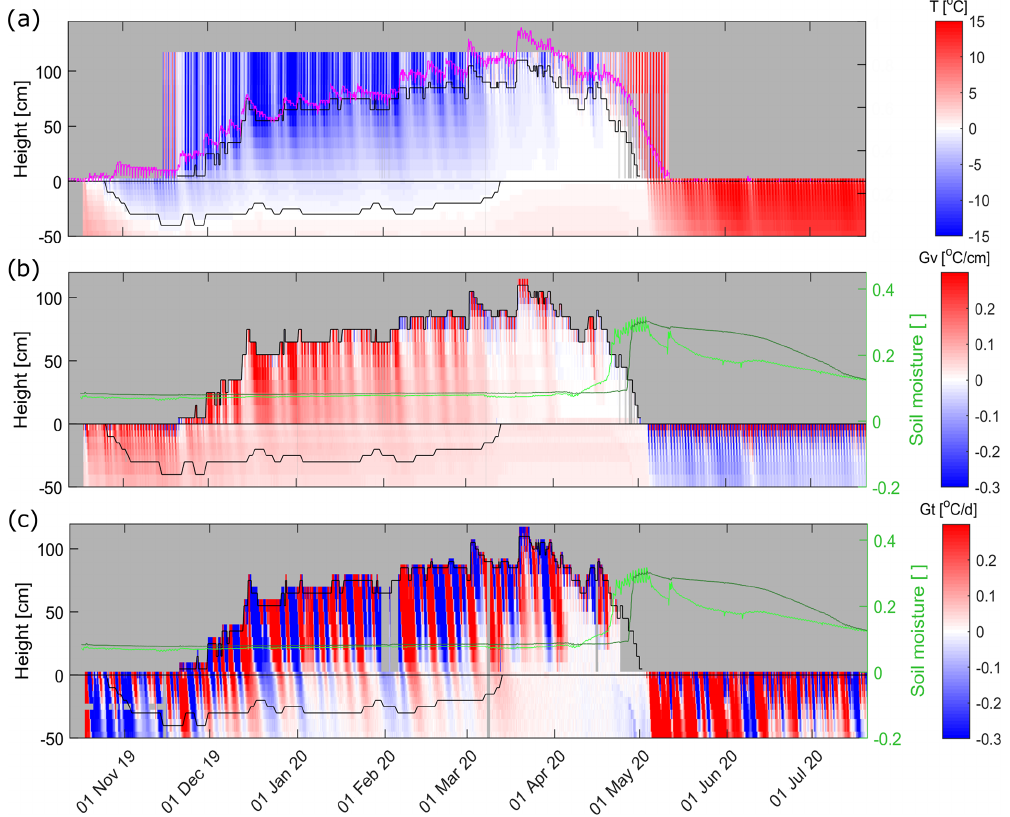
Figure 5. DTP systems deployed for snow and soil temperature measurements at a site in the East River (Colorado) watershed. The DTP- inferred snow depth (aboveground black line) and soil frozen-layer thickness (belowground black line) are overlaid on the DTP (a) tempera- ture ( T ), (b) its vertical gradient (Gv) at each sampling time, and (c) the temporal change in temperature (Gt) after averaging the time series with a moving 24h time window. The pink line shows the snow depth from the Butte SNOTEL station located 2km away and at a 350m higher elevation. The light and dark green lines indicate the soil moisture (m 3 m − 3 ) at 10 and 50cm depth, respectively. Color scales have been cropped to the displayed minimum and maximum values in order to improve visualization. Please note that the date format in this figure is day month